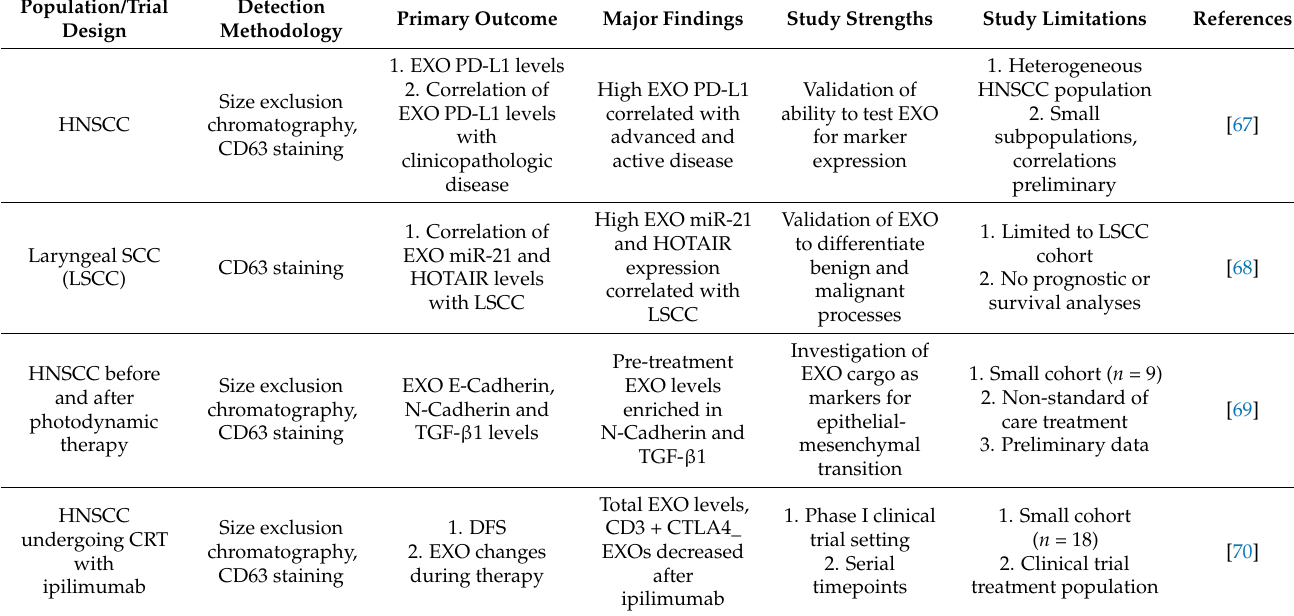
Table 3. Key studies investigating exosomes (EXOs) as biomarkers in